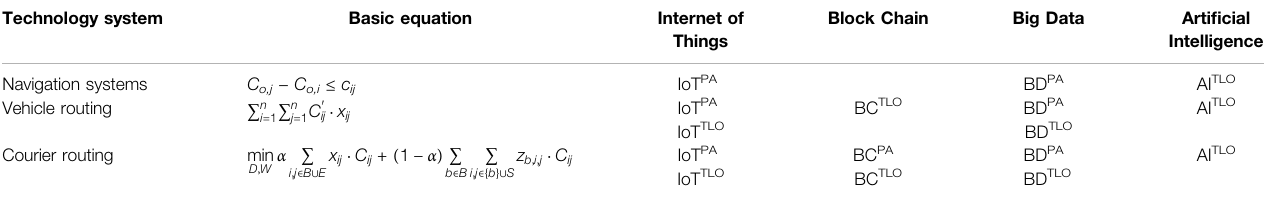
TABLE 1 | Synoptic overview on technologies and freight transport management